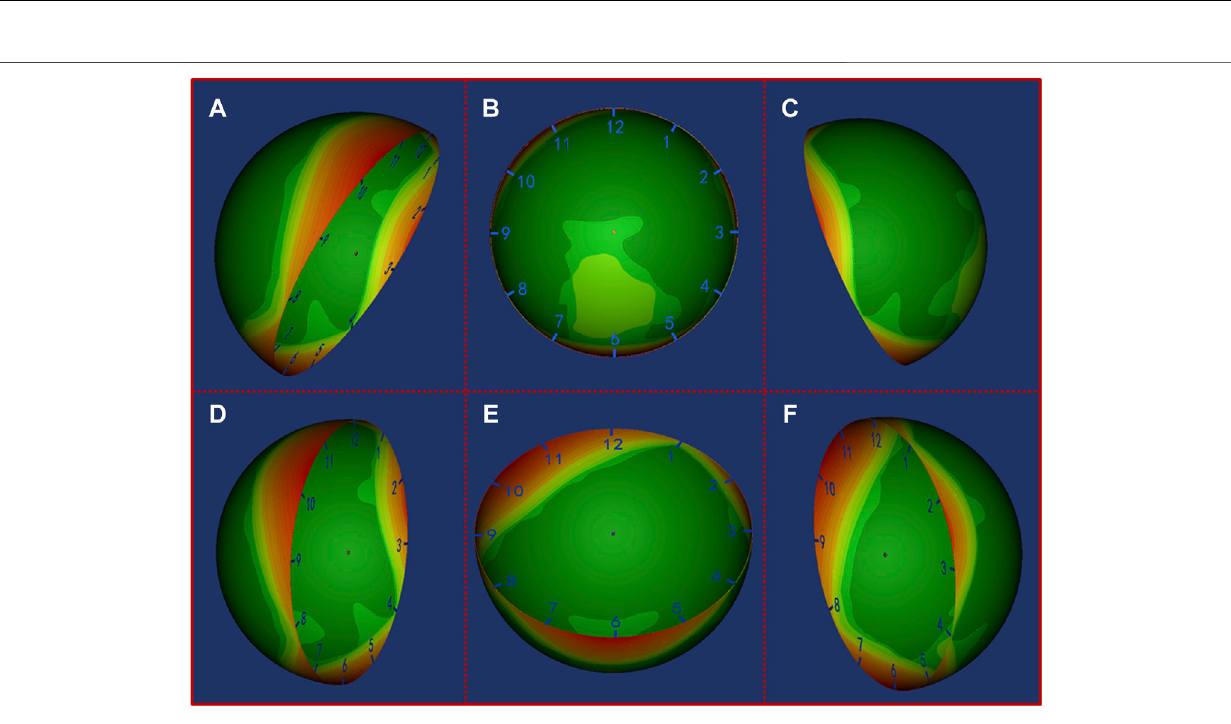
FIGURE5| DistributionmapoftheuncoveredareainAAOSIIgroup.Greentoredindicatesthattheuncoveredfrequencyrangesfromlowtohigh. (A) Frontviewof thepelvis, (B) openingorientationviewofthecup, (C) Backviewofthepelvis, (D) Lateralviewofthecupfromfronttoback, (E) Lateralviewofthecupfrombottomtotop, (F) Lateral view of the cup from back to